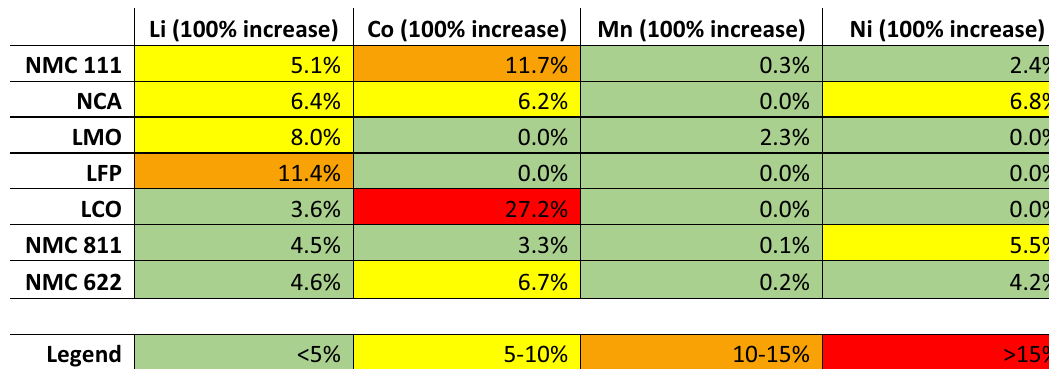
Fig. 6 Impact of cathode material price changes on overall Li-ion bat- tery cost. The percent change in material price on the x axis assumes the same change is applied to all four materials being considered. The black dots on each of the chemistry lines are representative of the bat-